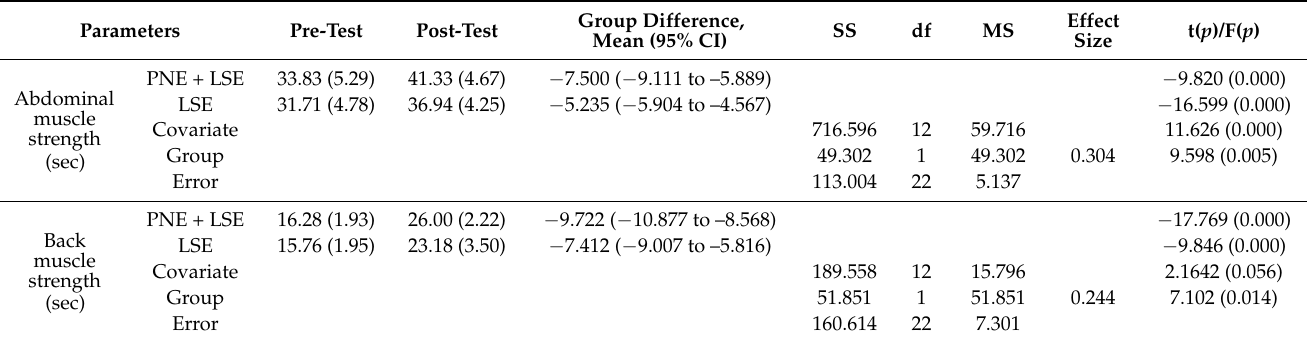
Table 4. Comparison of muscle strength within groups and between groups ( N =